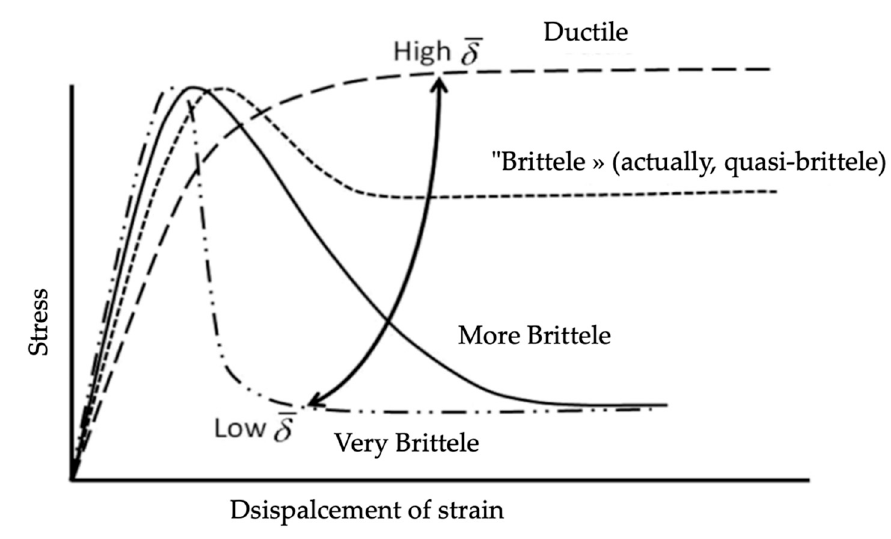
Figure 6. Representation of the brittleness of clay [15].